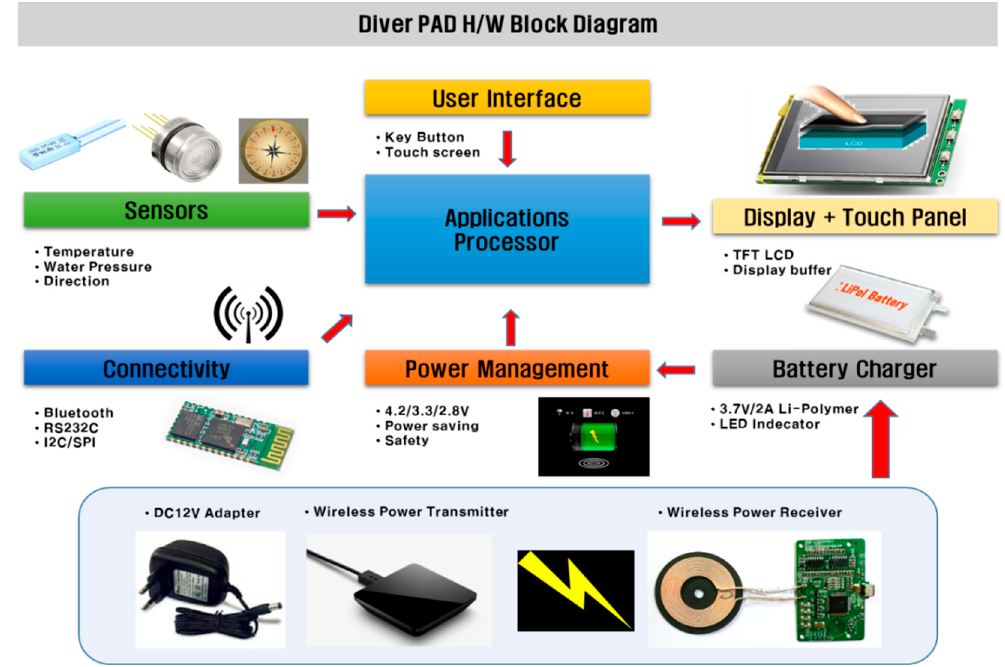
Figure 4. Block diagram of DiverPAD.